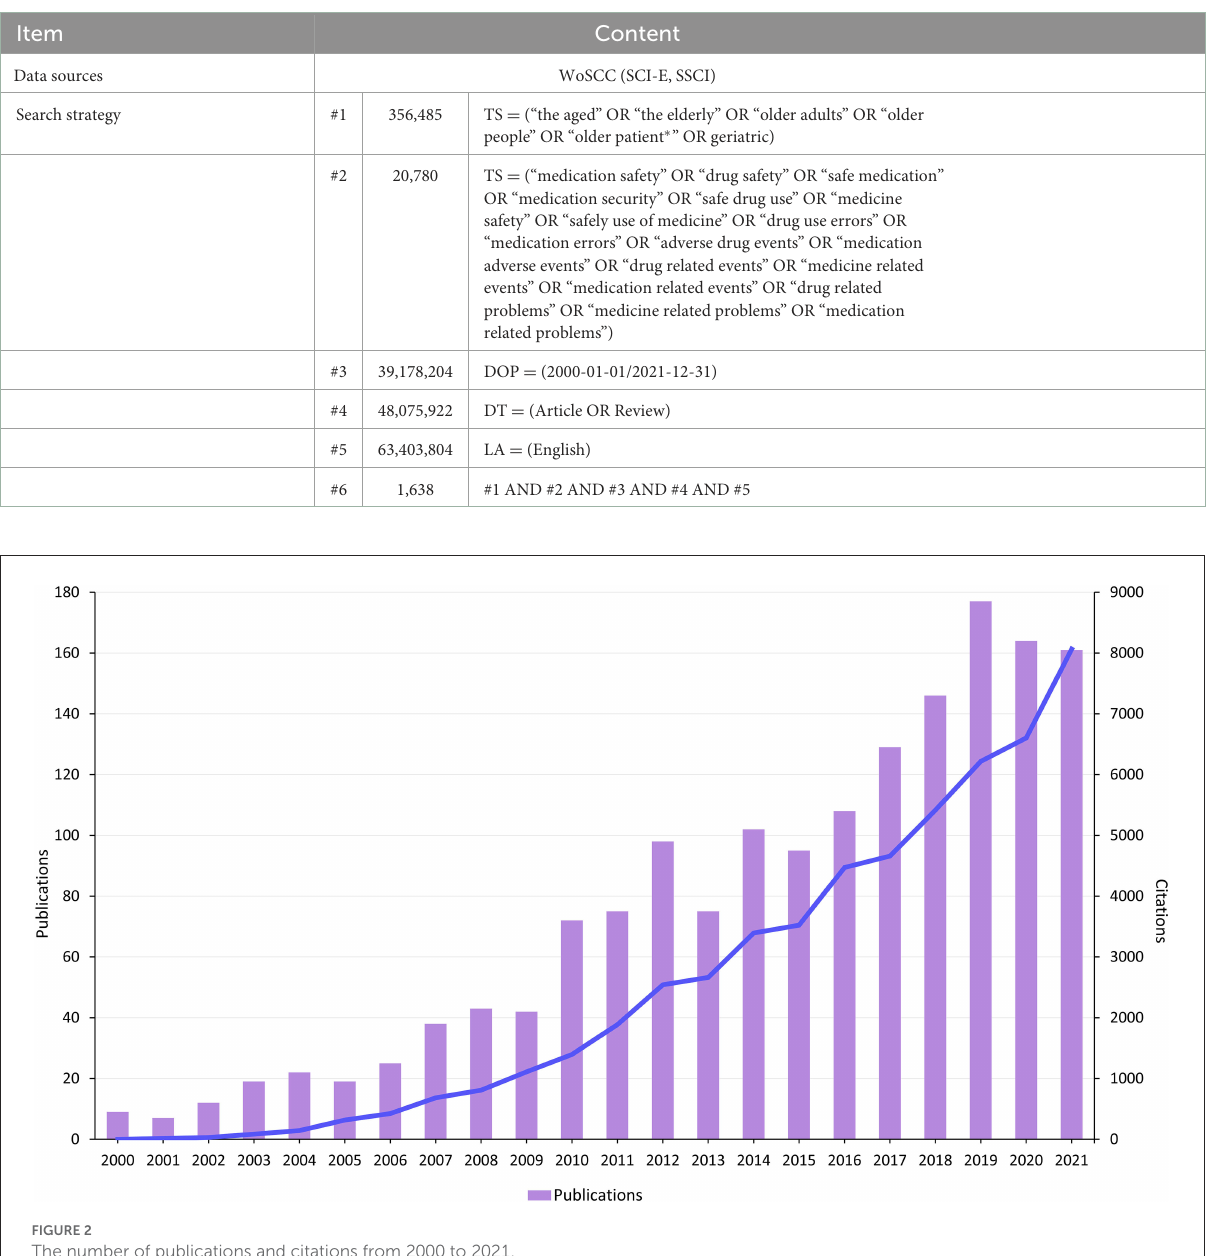
FIGURE2 The number of publications and citations from 2000 to